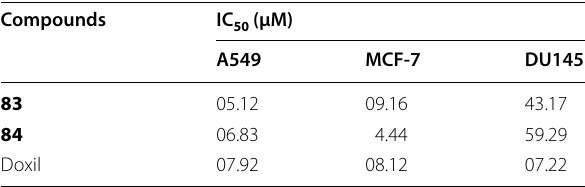
Table 27 IC value of synthesized derivatives against can- 50 cer cell lines